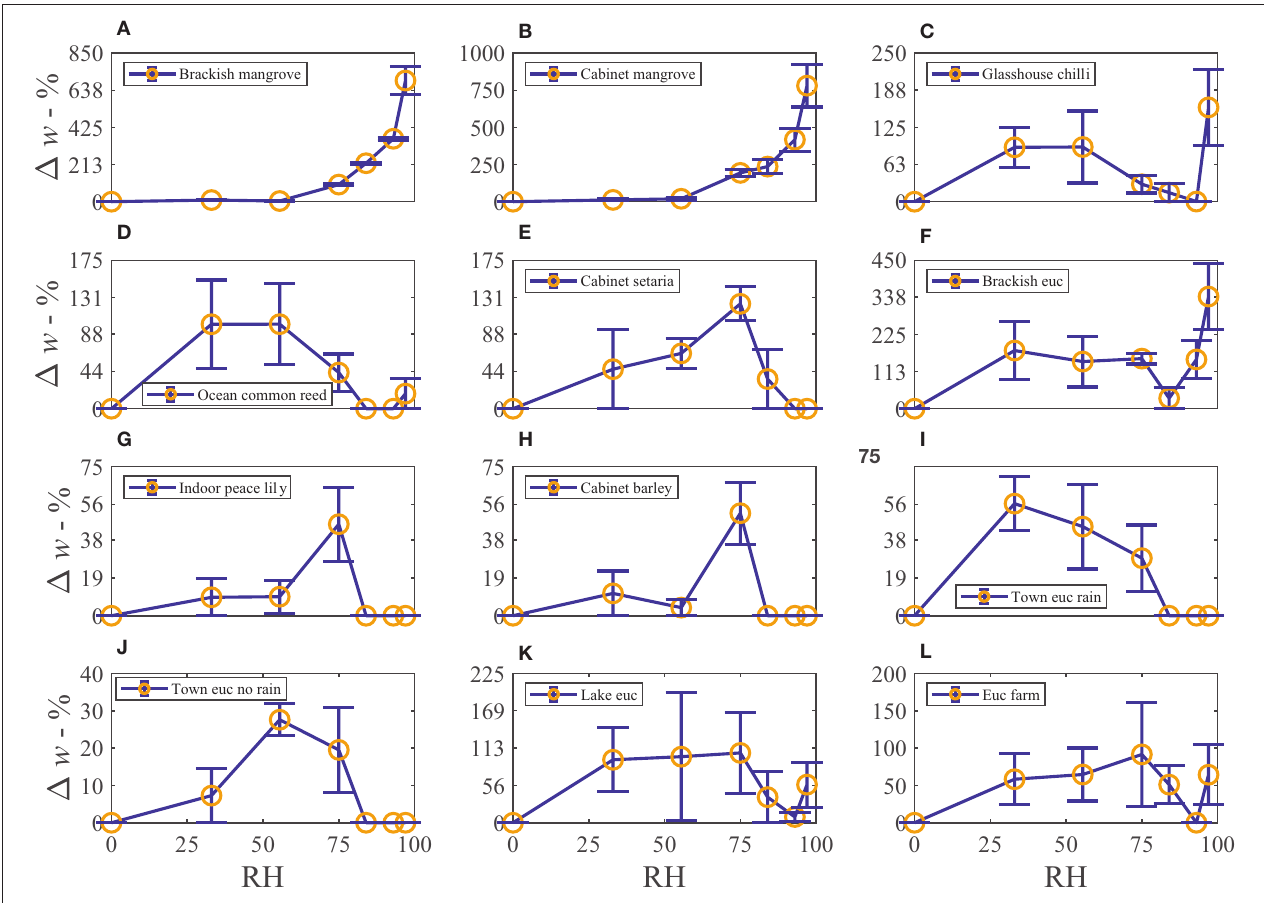
FIGURE 2 | The percentage weight increase of moisture adsorbed of the leaf wash samples, 1 w - %, vs. relative humidity, RH - %, plotted with standard error bars. Each leaf wash sample is shown in (A–L) . Note the x -axis range is always the same but the y -axis range changes for each